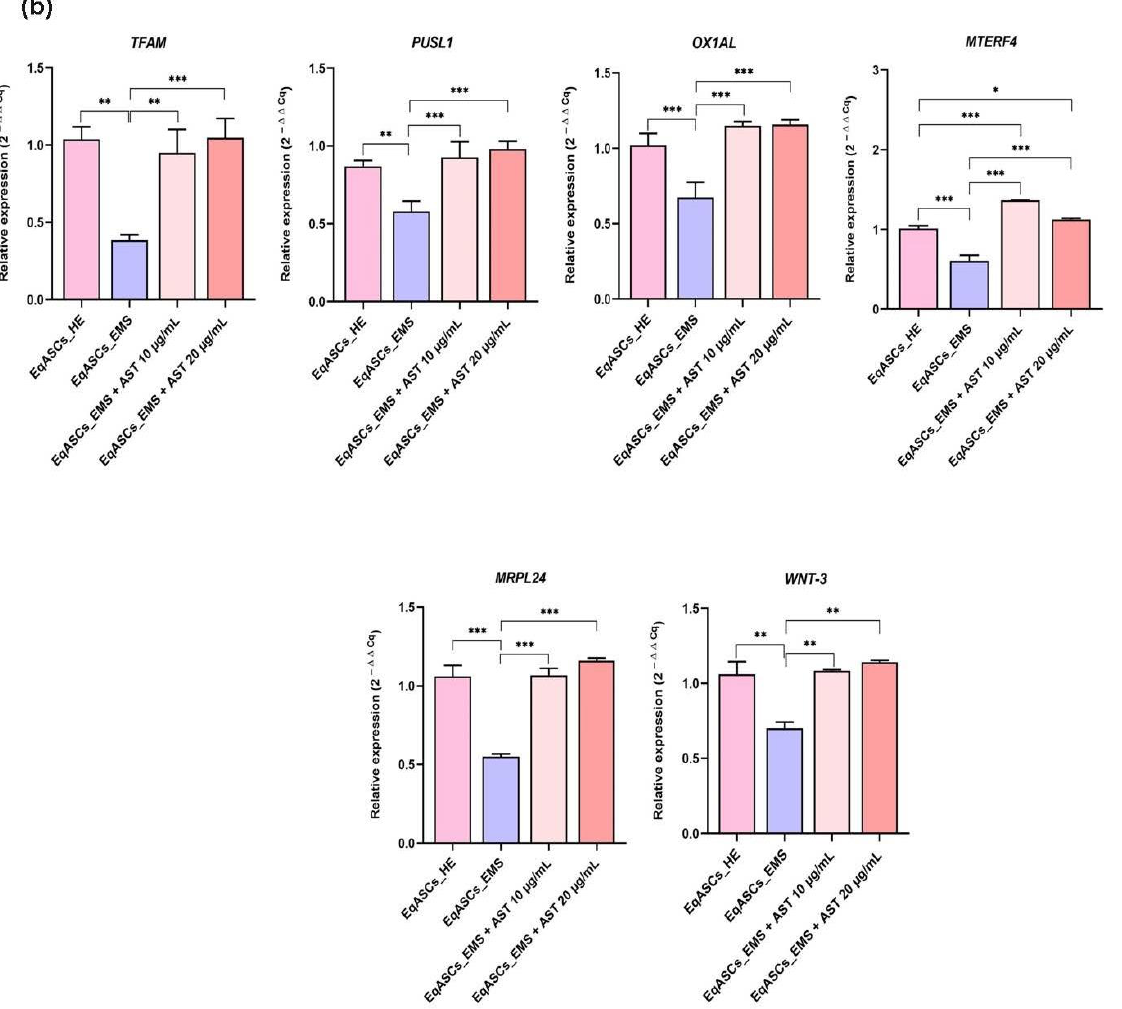
Figure 5. Effect of Astaxanthin on Mitochondrial metabolism. Expression of ( a ) genes encoding for the OXPHOS complexes ( b ) genes encoding of mitochondrial translational machinery regulators. A comparison of EMS, treatment groups and untreated healthy cells is shown by an asterisk (*). * p < 0.05, ** p < 0.01, *** p < 0.001.